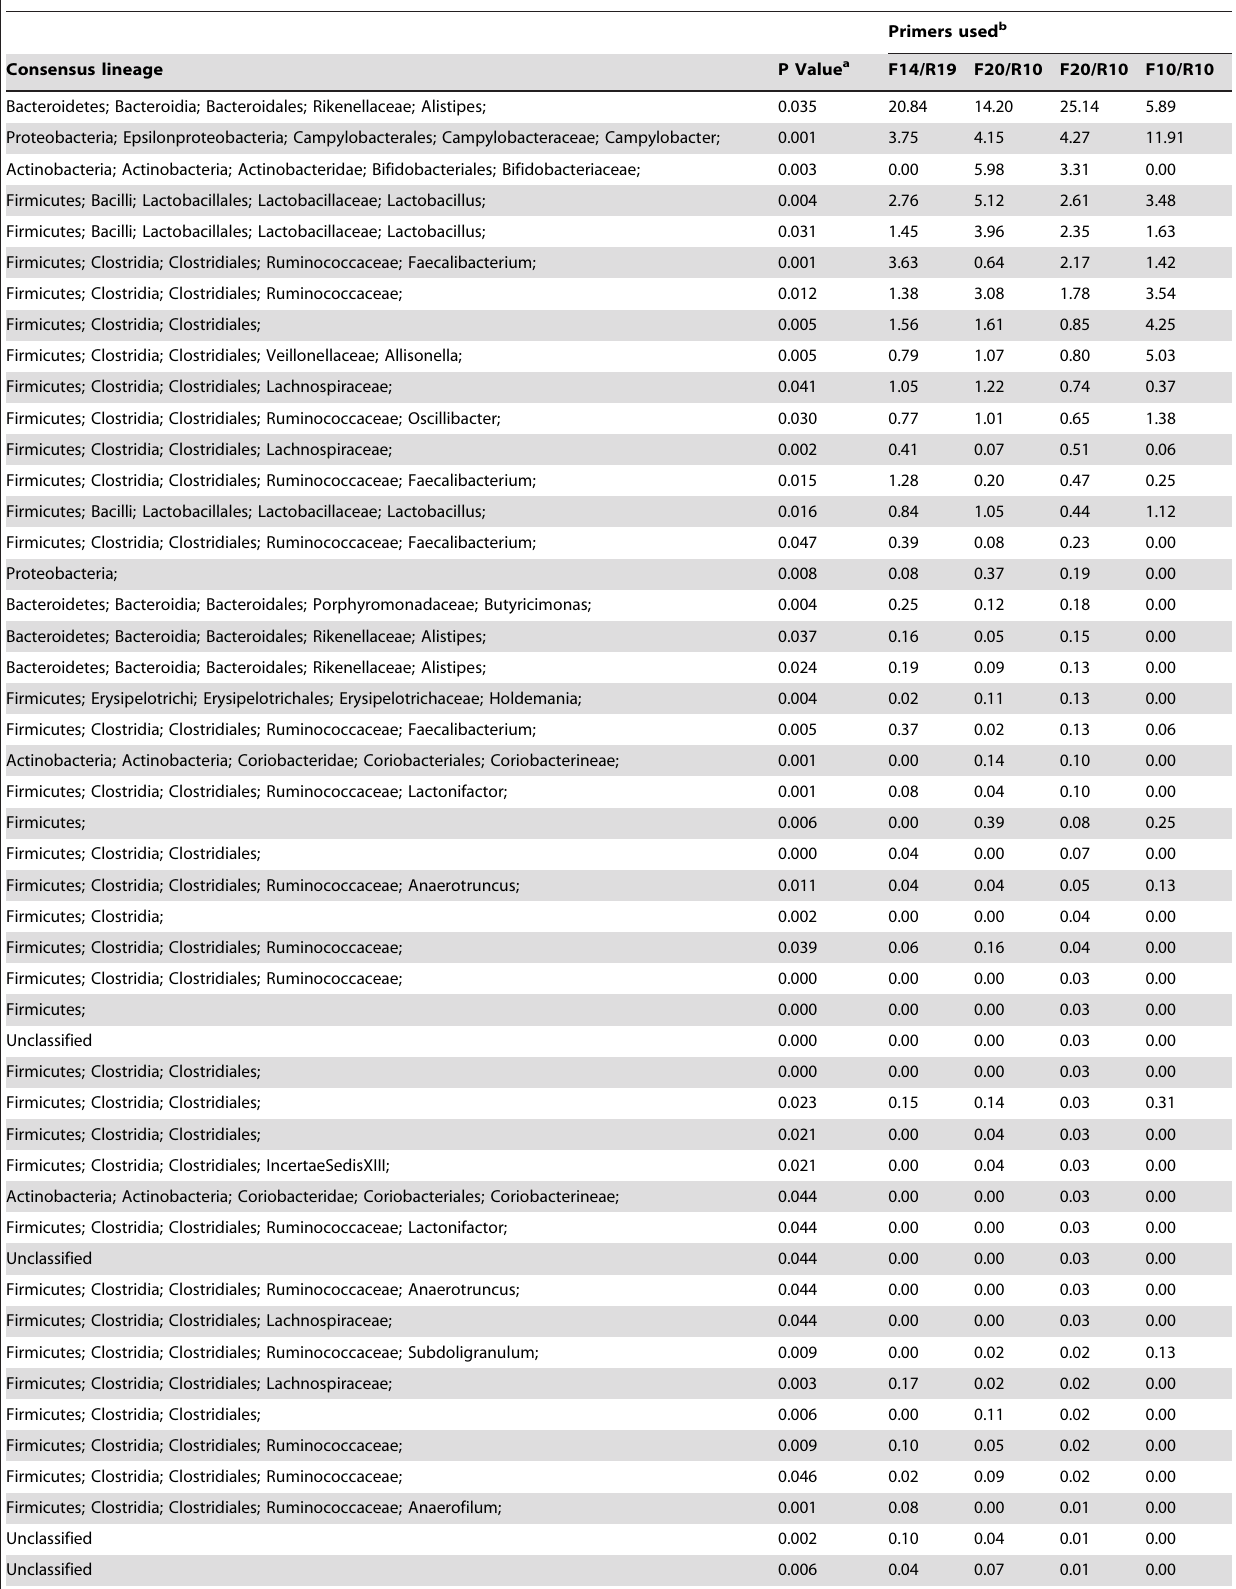
Table 3. OTUs which differed significantly when different primer pairs were employed in the